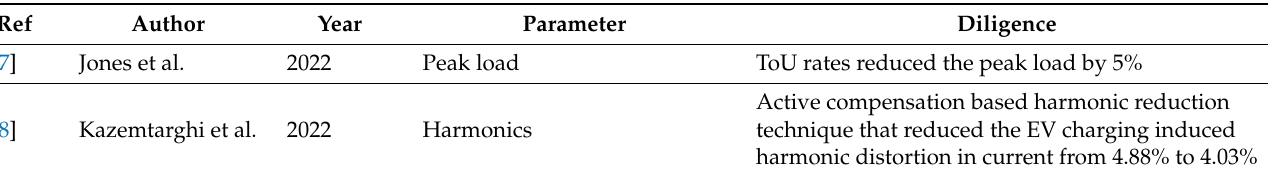
Table 3. Research work on impact of EV on power